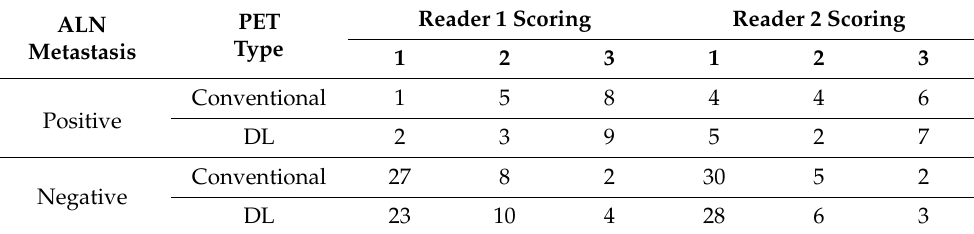
Table 5. Scores by each reader for axillary lymph node (ALN) metastasis on visual analysis *.